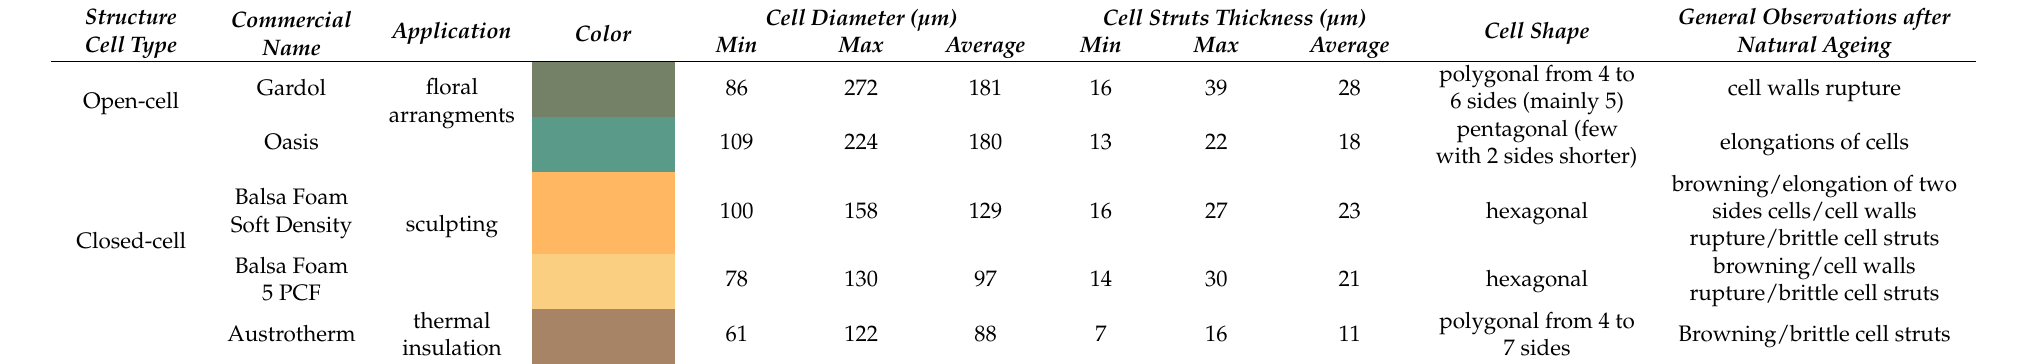
Table 1. List of the phenol formaldehyde (PF) foams investigated, distinguished according to their cell type, commercial name, application, color, cell structure characteristics, and general observations summarized after natural ageing (two months for open-cell foams and two years closed-cell